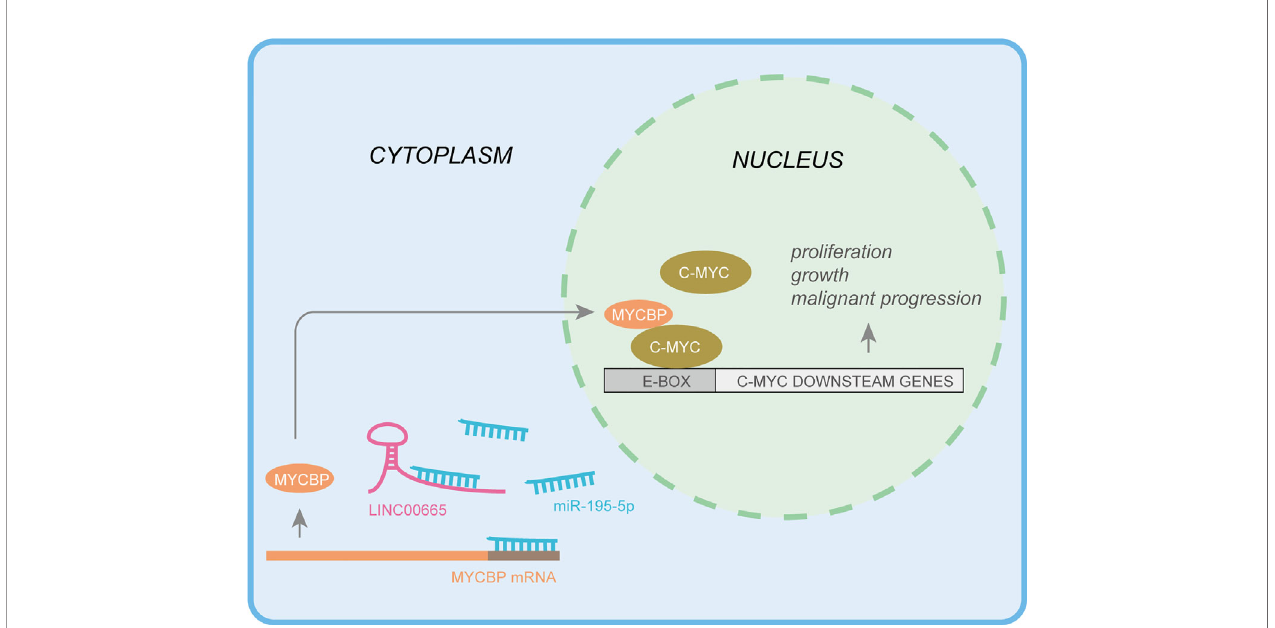
FIGURE 7 | Integrated model depicting LINC00665 driving LUAD